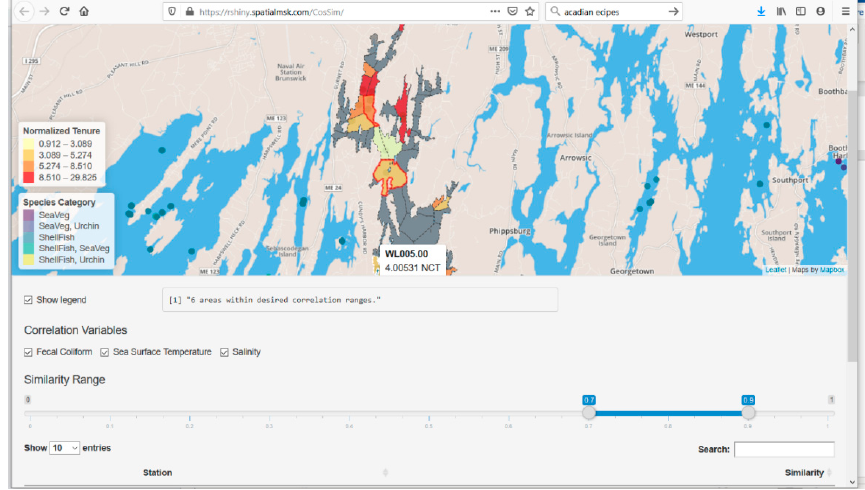
Figure 8. A screenshot of the R Shiny interface. When a user selects a Voronoi characterization zone, the application reports the most similar zones based on the underlying physical properties. The most similar cells are highlighted in red on the map.